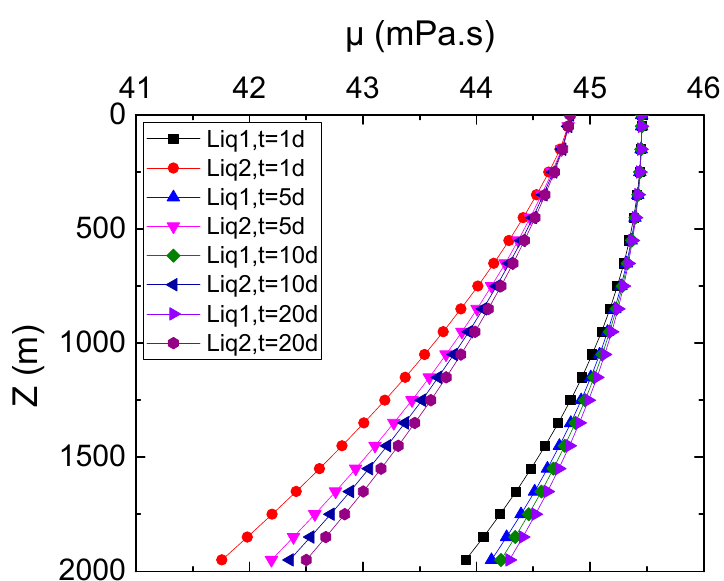
Figure 9. The influence of injecting time on viscosity. As injecting time increasing, the viscosity at bottom slightly increases. Generally, the influence of injecting time is slight compared with injecting rates.